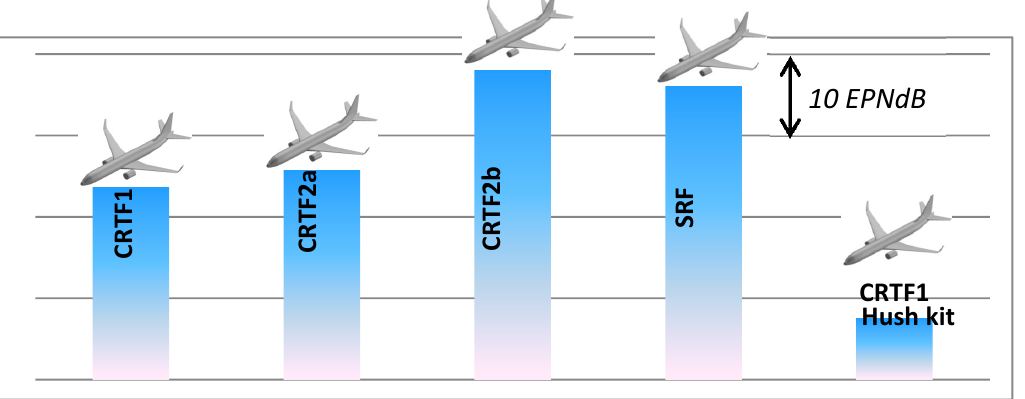
Figure 7. CIAM estimations of the VITAL project results.